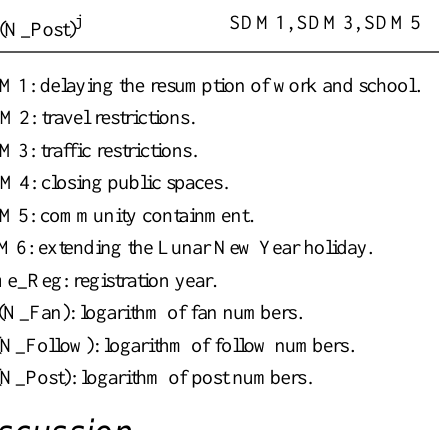
The measures make the explanatory variables have a nega- tive tendency toward